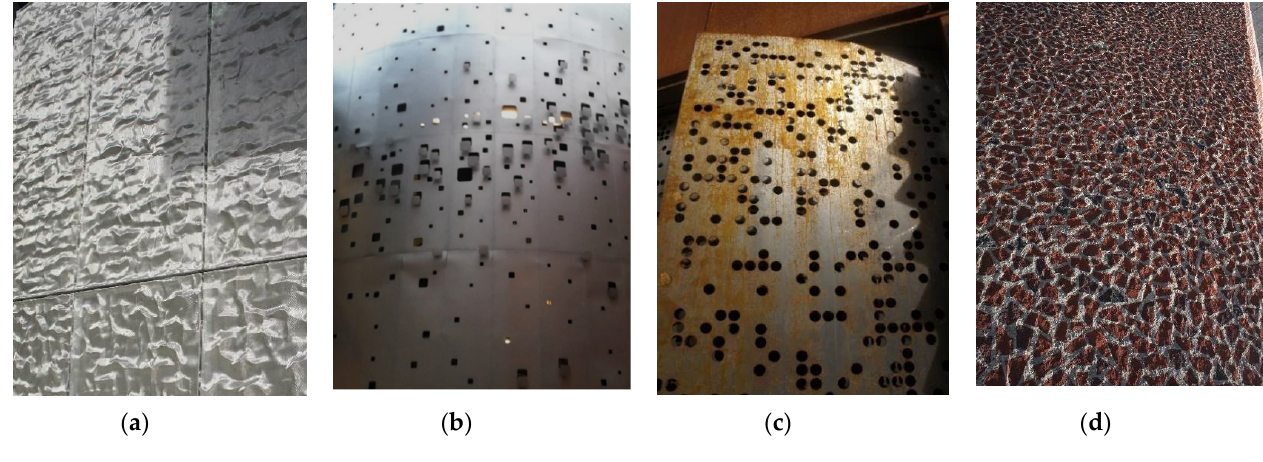
Figure 3. Application of ADAD concept in relief composition of building enclosure; ( a ) Façade cladding in wrinkled steel mesh, pavilion, EXPO Milan, 2015 (Photo by M. Celadyn); ( b ) Inner courtyard walls’ cladding with perforated stainless steel sheeting, Stary Browar (Old Brewery) Commercial Center, Poznan, Poland, arch. ADS Studio, R. Kaja, 2007 (Photo by W. Celadyn, 2014); ( c ) The external pivoting doors with perforated steel and stains from the Corten-finished walls’ cladding, British pavilion, EXPO Milan, 2015, (Photo by M. Celadyn); ( d ) External wall cladding with picado technique, CKK Jordanki Congress and Culture Centre, Torun, Poland, arch. Menis Arquitectos, 2015 (Photo by M. Celadyn).